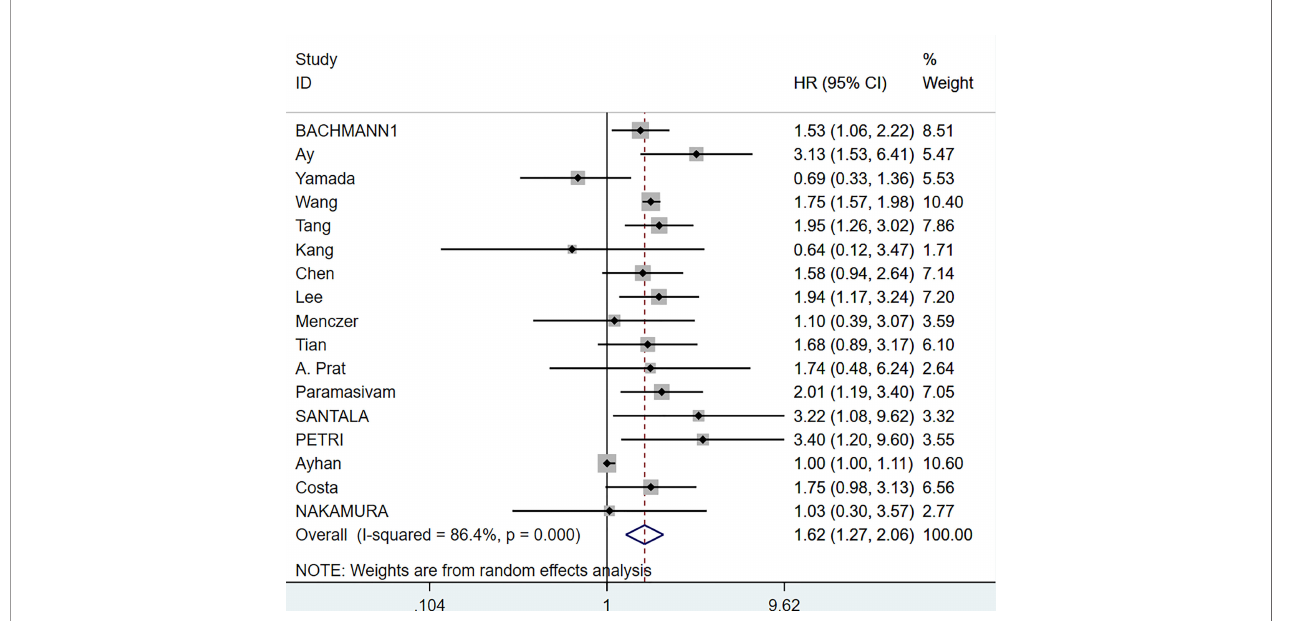
FIGURE 2 | Forest plot of the association of CA-125 with OS in EOC cancer patients. CI, con fi dence interval; HR, hazard